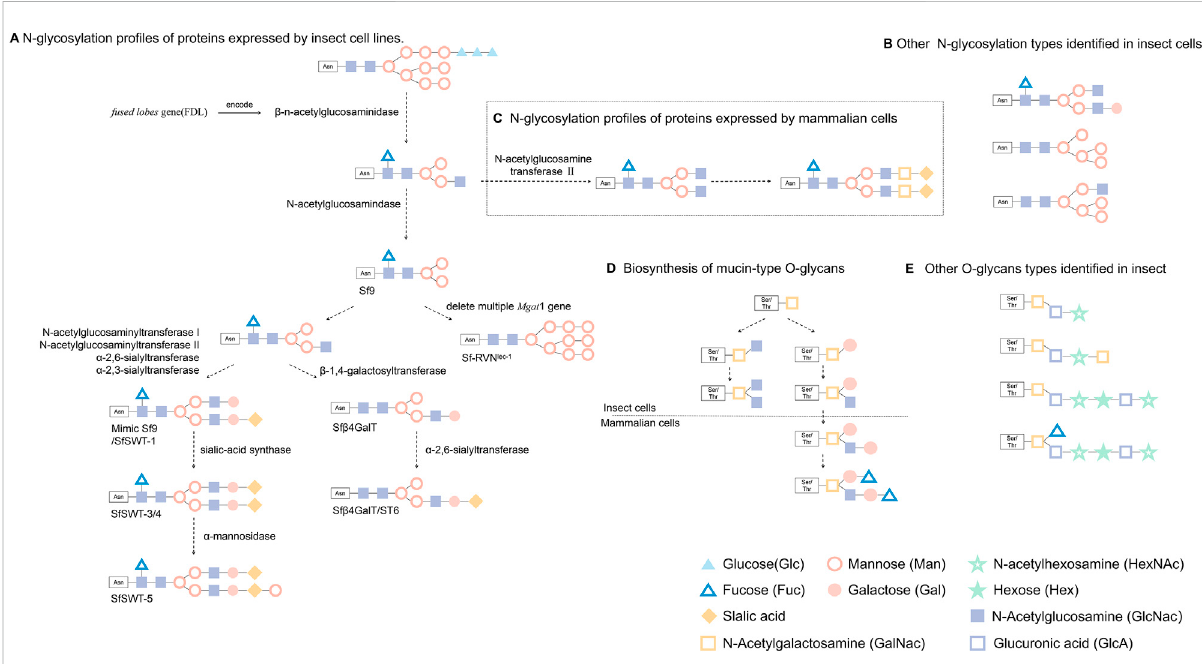
FIGURE 2 Glycosylation of foreign proteins expressed in eukaryotic cells. (A) Recombinant protein produced by BEVs after β -n-acetylglucosaminidase catalysis result in simple paucimannosidic structure, while some lepidopteran cell lines after cell engineering can express proteins with above N-glycosylation. (B) Other N-glycosylation types identi fi ed in insect cells. (C) Exogenous proteins produced by mammalian cells were modi fi ed to formcomplexN-glycansstructure(This fi gureonlyshowsthegeneralsteps andacommon N-glycansstructure.) (D) Biosyntheticprocesses of mucin-type O-glycans that have been explored in insect cells and mammalian cells. (E) Other common O-glycans identi fi ed in fruit fl y larvae, mosquito larvae or Sf9 and High fi ve lepidopteran